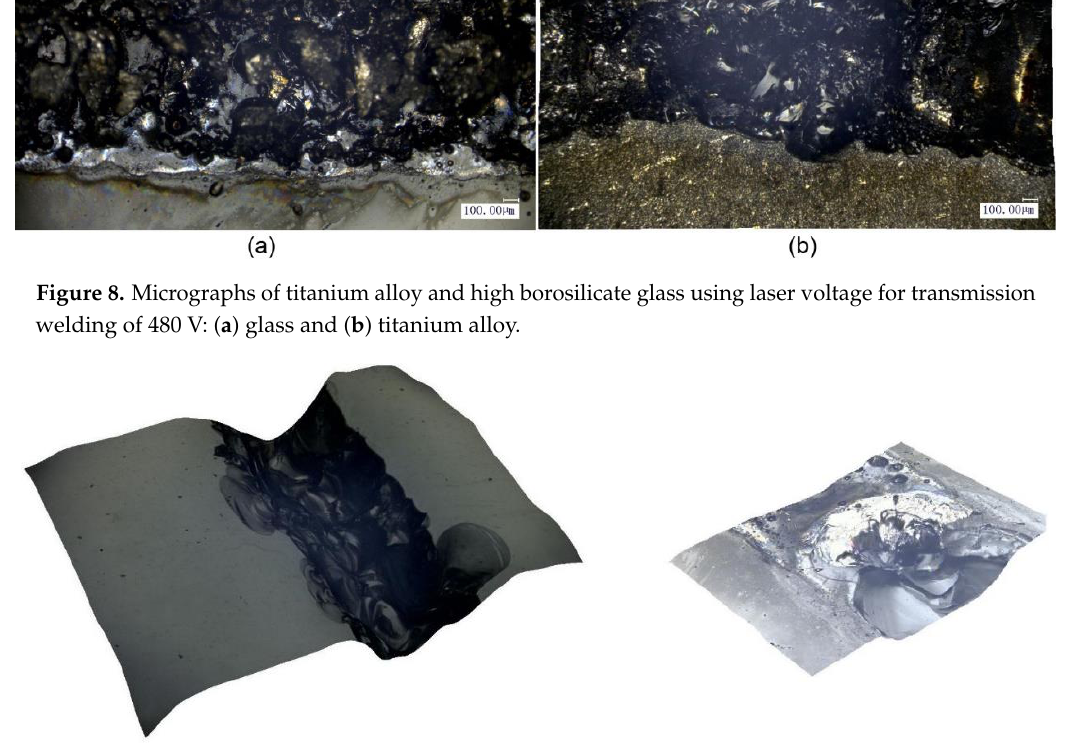
Figure 8. Micrographs of titanium alloy and high borosilicate glass using laser voltage for transmission welding of 480 V: ( a ) glass and ( b ) titanium alloy.